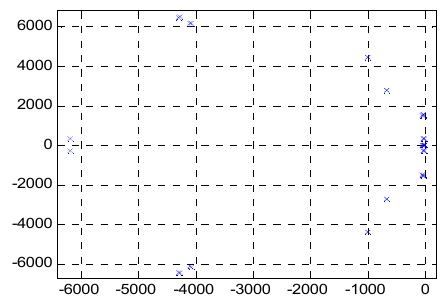
Figure 8. The root locus of the proposed multi-inverter-based micro-grid system.